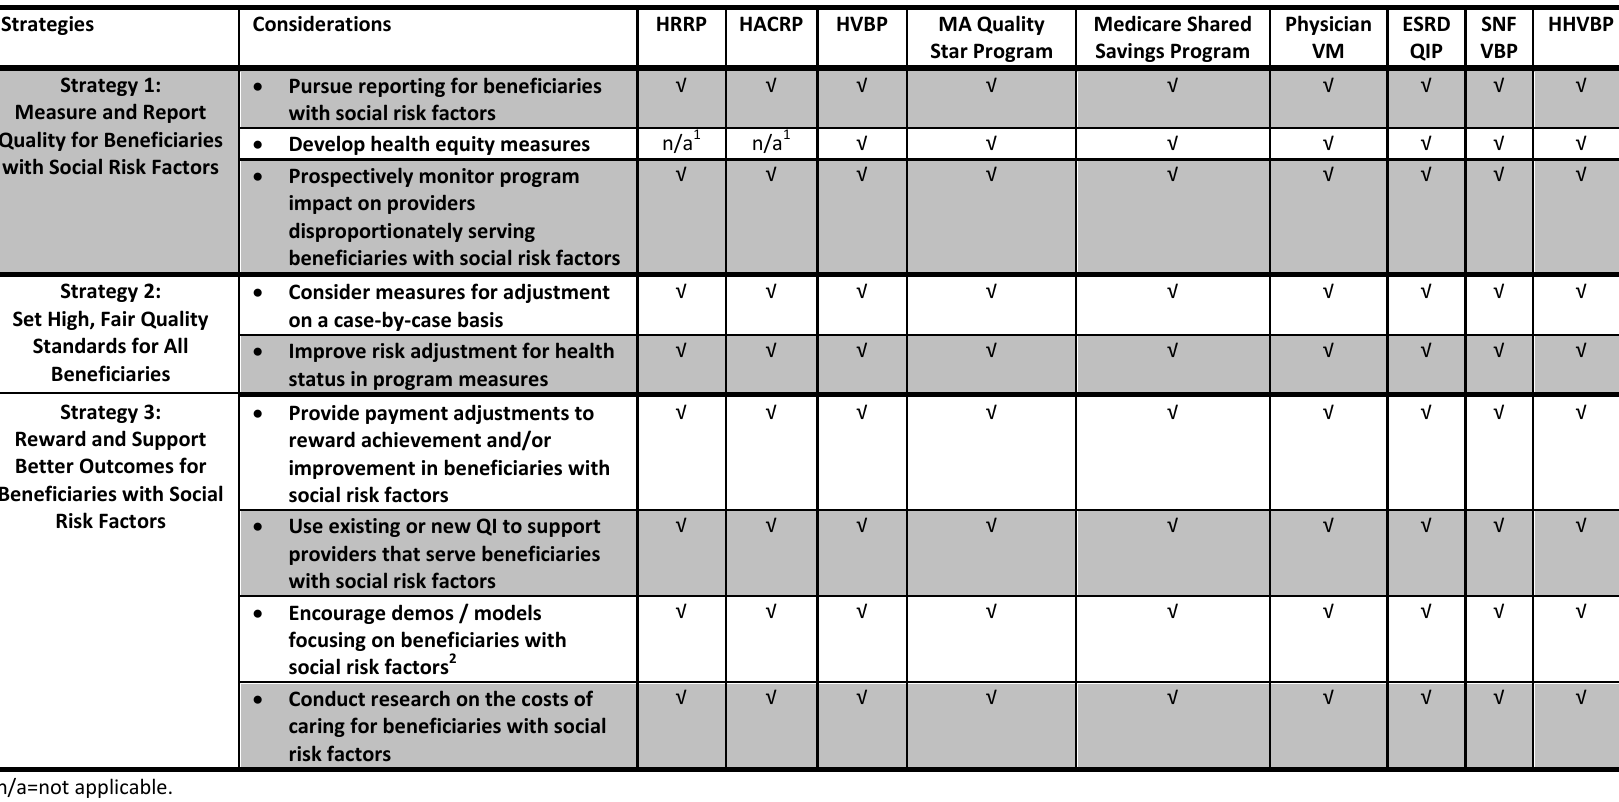
Table 2: Application of Considerations to Programs in this report